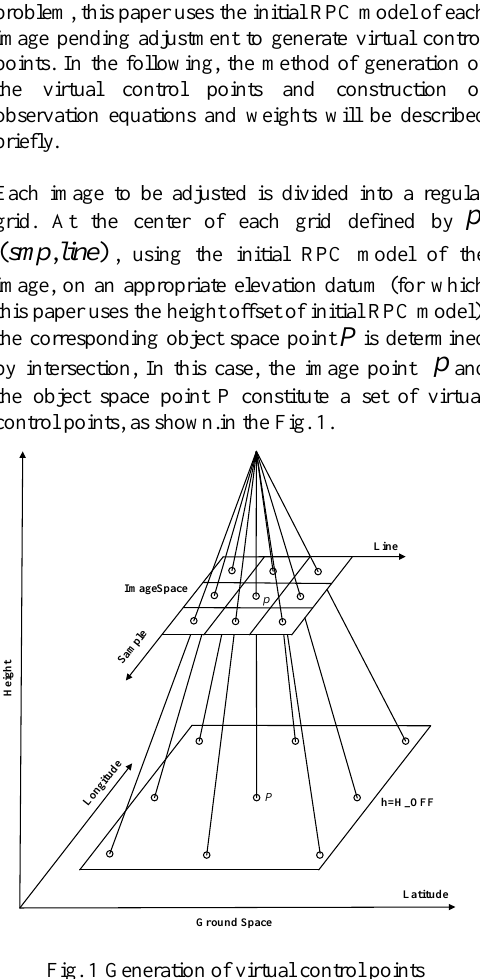
Fig. 1 Generation of virtual control